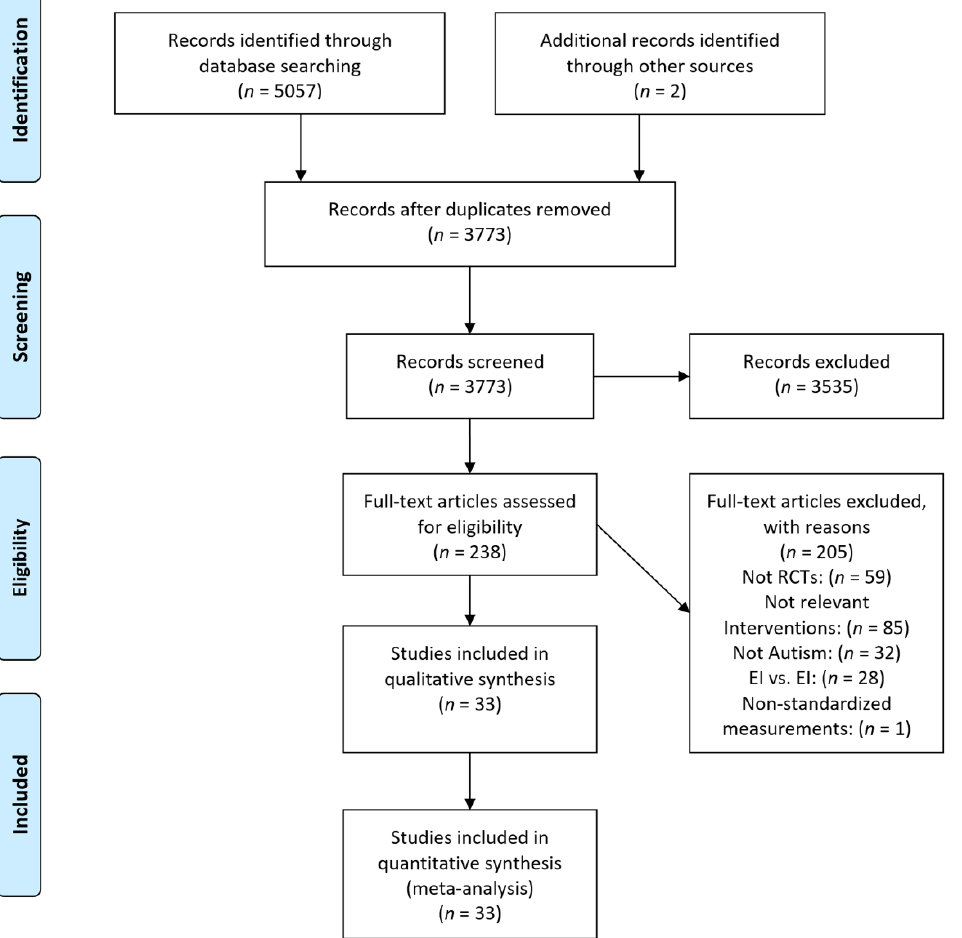
Figure 1. Flow diagram of study selection.